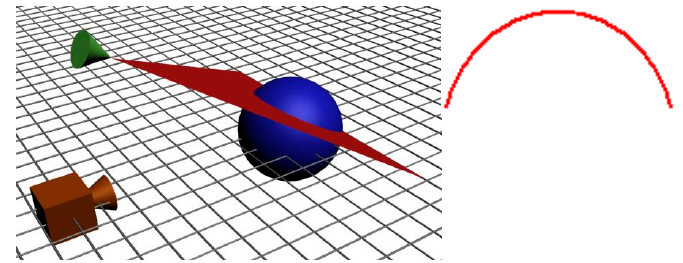
Figure 2. Projection of a laser light plane on a surface.